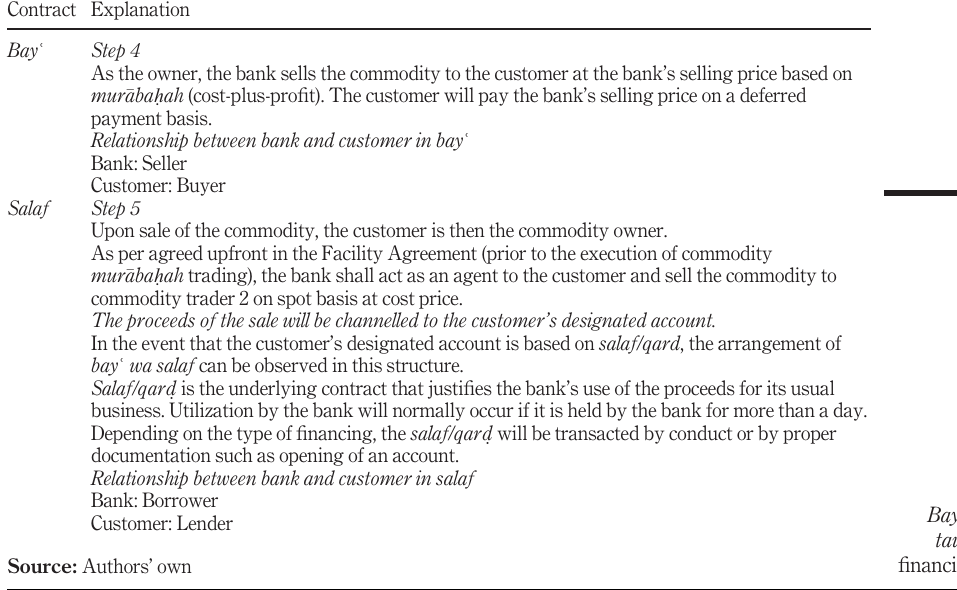
Table II. Bay ʿ and salaf